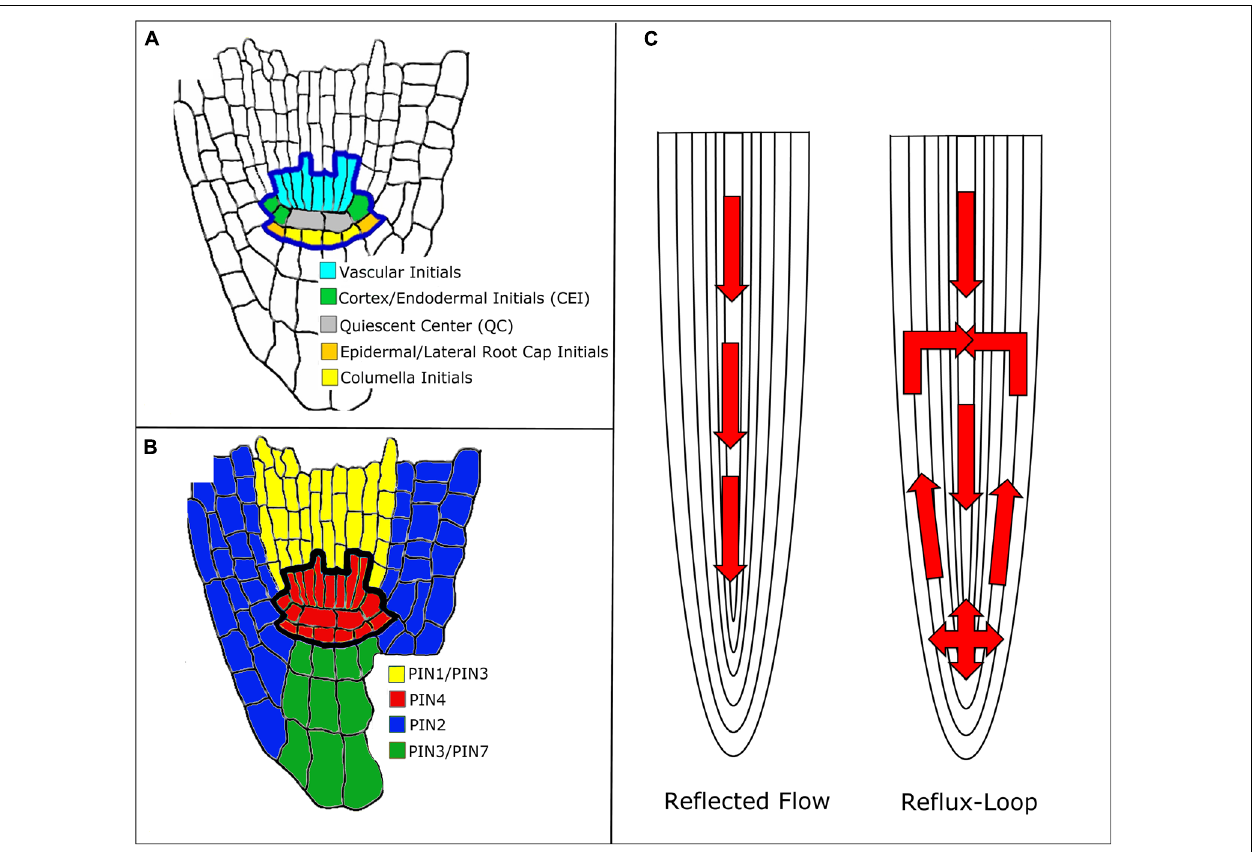
FIGURE 1 | Mechanisms of auxin transport in the Arabidopsis root. (A) Root stem cell niche (SCN) organization. (B) PIN protein localization around the SCN. Note that the colors do not represent the exact localization